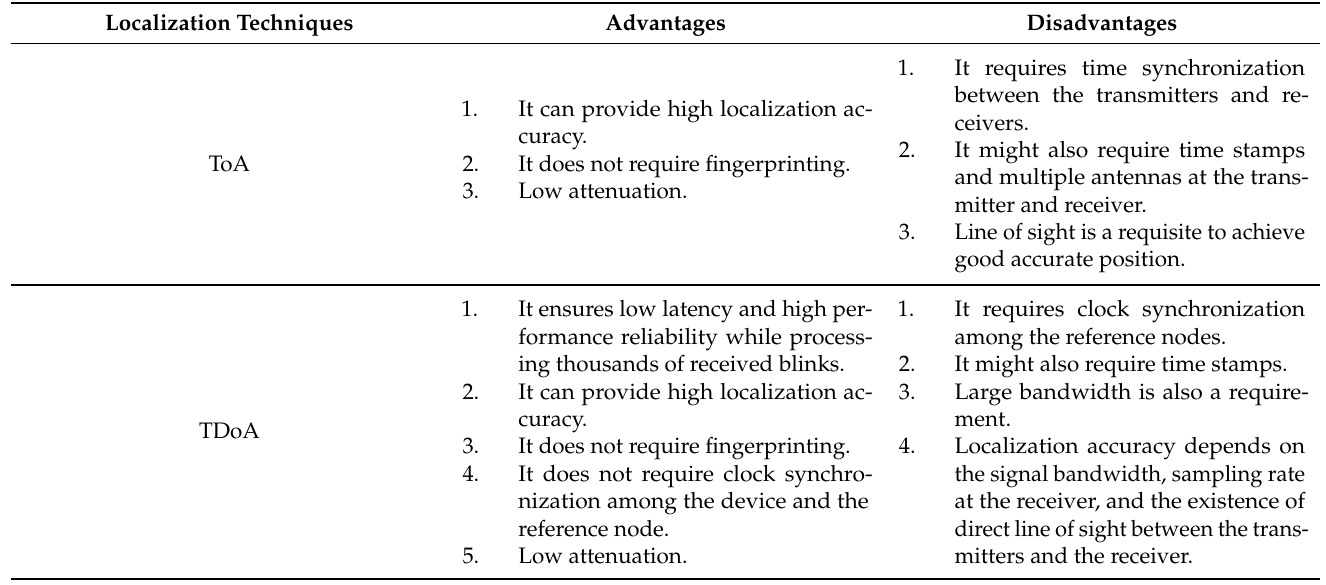
Table 1. Pros and cons of different localization